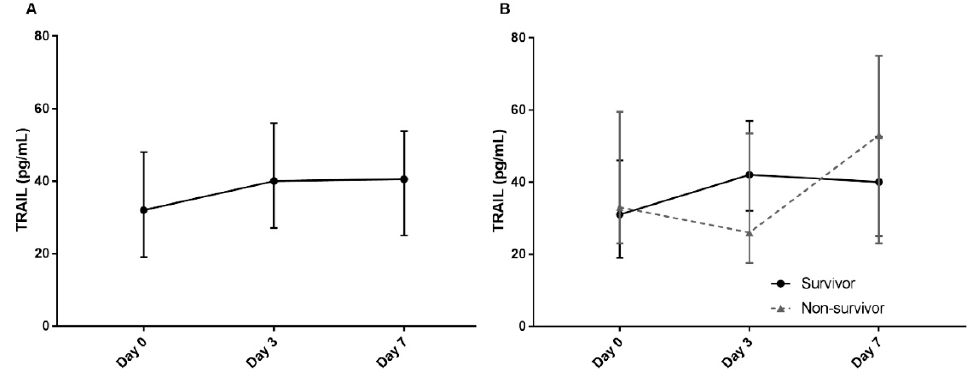
Figure 5. ( A ) Serial plasma levels of TRAIL on days 0, 3, and 7 of 143 patients with sepsis. ( B ) Comparison of serial plasma TRAIL levels in 28-day intensive care unit survivors (solid line) and non-survivors (dotted line). Upper and lower bars represent the 75th and 25th interquartile ranges, respectively.